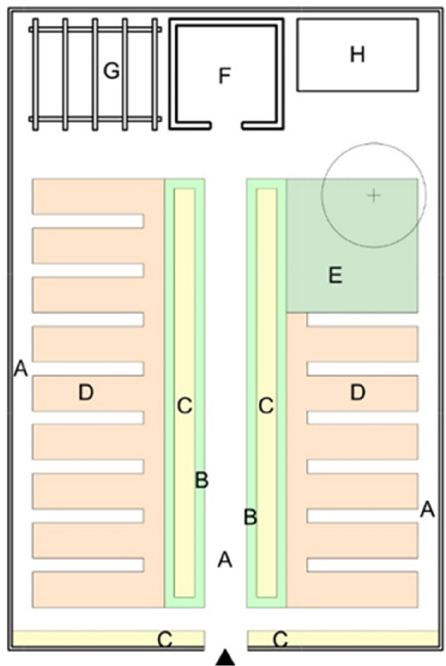
Figure 2. Scheme of a typical lot in the Schrebergärten garden colony in Leipzig, 1909. A—paths, B—decoration hedge, C—decoration flowers, D—edible plants, E—fruit trees, F—summerhouse, G—terrace with construction for grapevine plants, H—composter (compiled by A. Nowysz, original study, based on local visit).